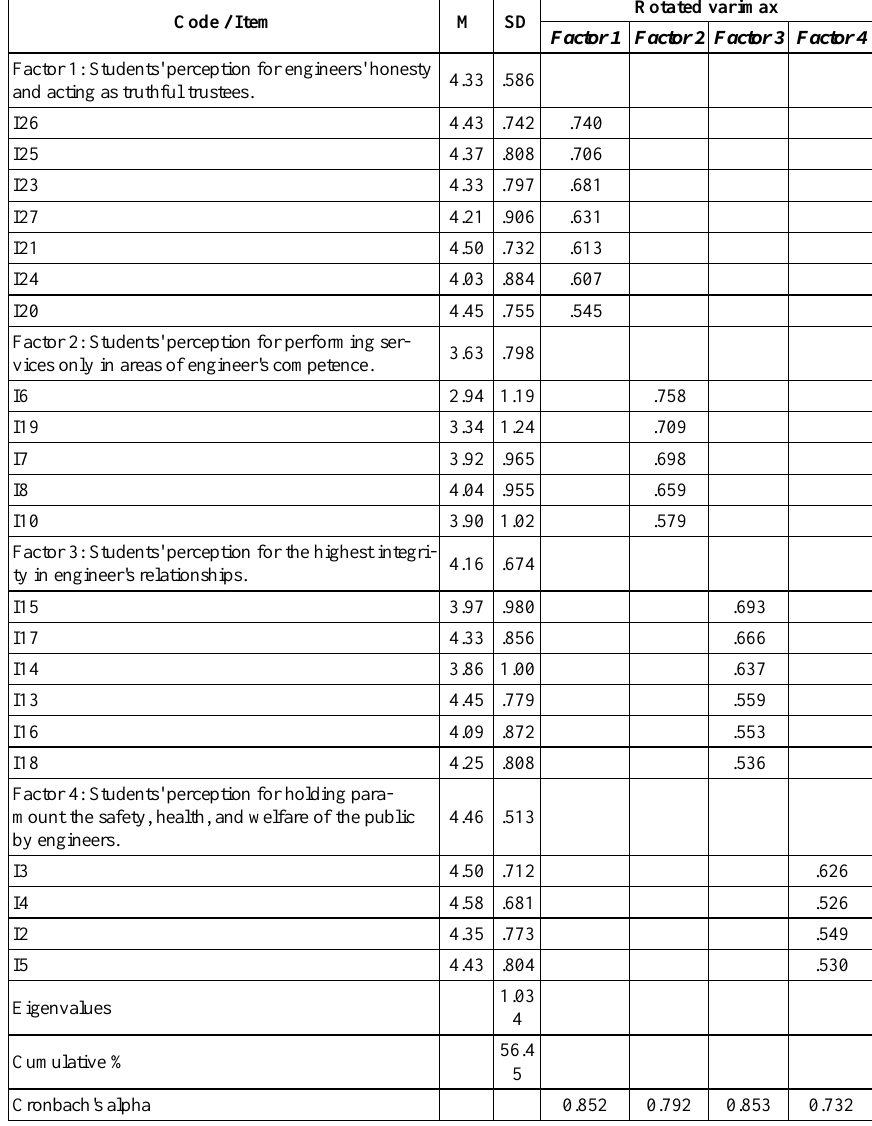
Table 3. Factor analysis for the ethical perception of engineering